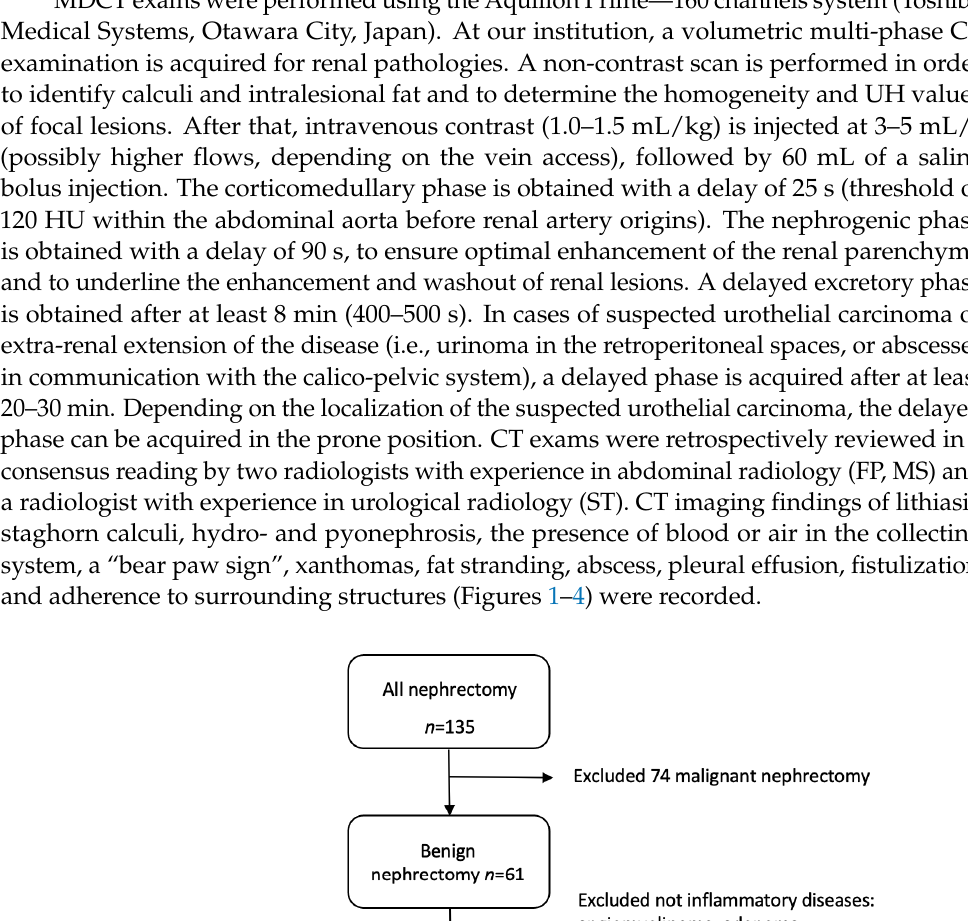
Figure 2. ROC curve of prediction model.